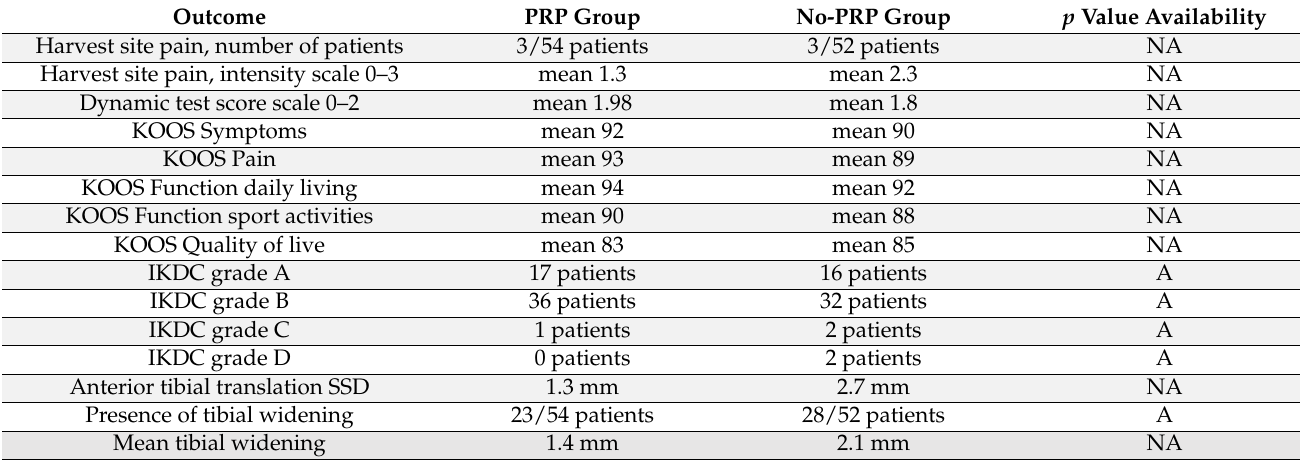
Table 2. Functional outcomes at 18 months